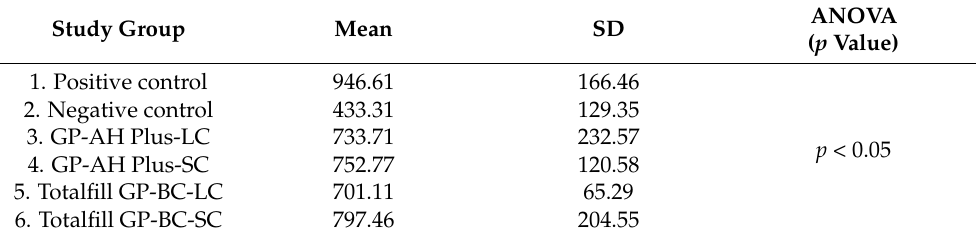
Table 1. Means and SD of vertical root fracture resistance among study groups. Study Group Mean SD